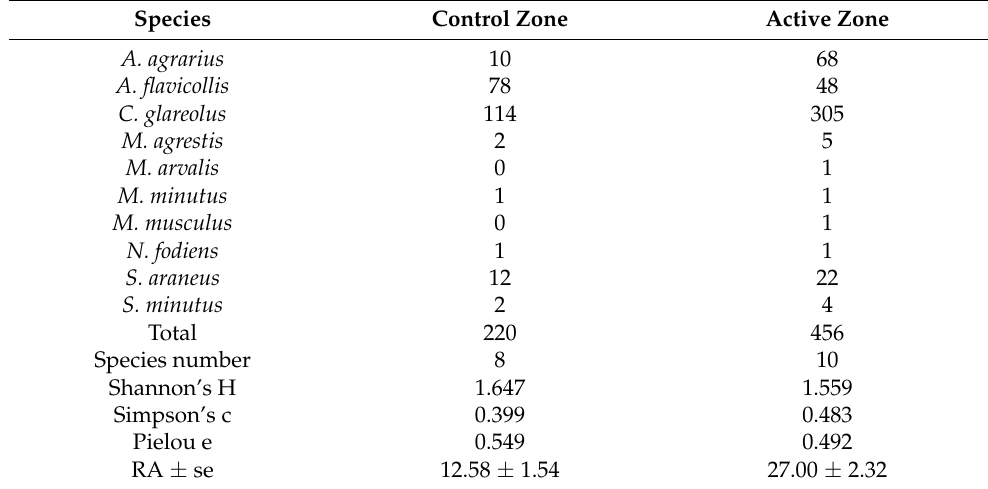
Table 2. Small mammal community structure, diversity, and relative abundance in Lukštas cormorant colony,